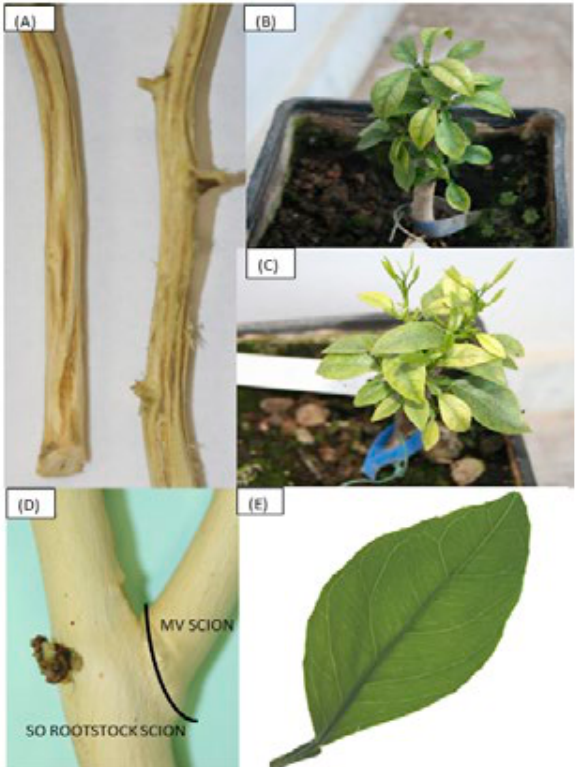
Figure 3. Symptoms recorded for isolate 6B associated with the T3-like genotype. (A) Stem pitting on Mexican lime. (B) Severe seedling yellow reaction on sour orange. (C) Se- vere seedling yellow reaction on Duncan grapefruit. (D) Inverse pitting on sour orange (SO) grafted with Madame vinous (MV). (E) Vein clearing on Mexican